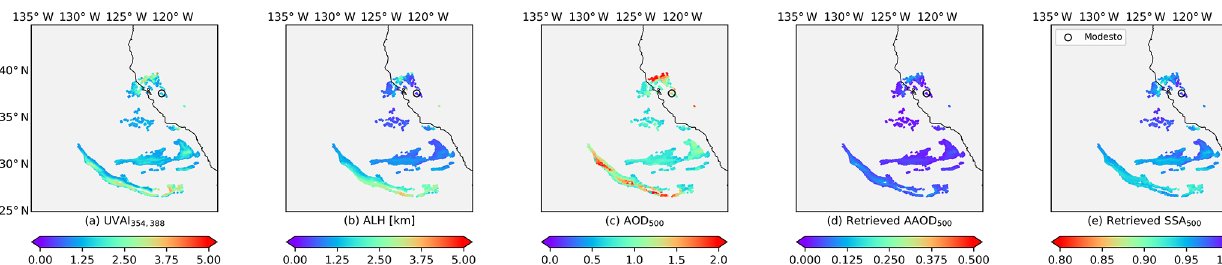
Figure 13. SVR retrievals for the Californian fire event on 11 November 2018: (a) TROPOMI UVAI calculated by reflectance at 354 and 388nm; (b) TROPOMI ALH; (c) MODIS AOD at 550nm; (d) retrieved AAOD at 500nm; (e) retrieved SSA at 500nm.